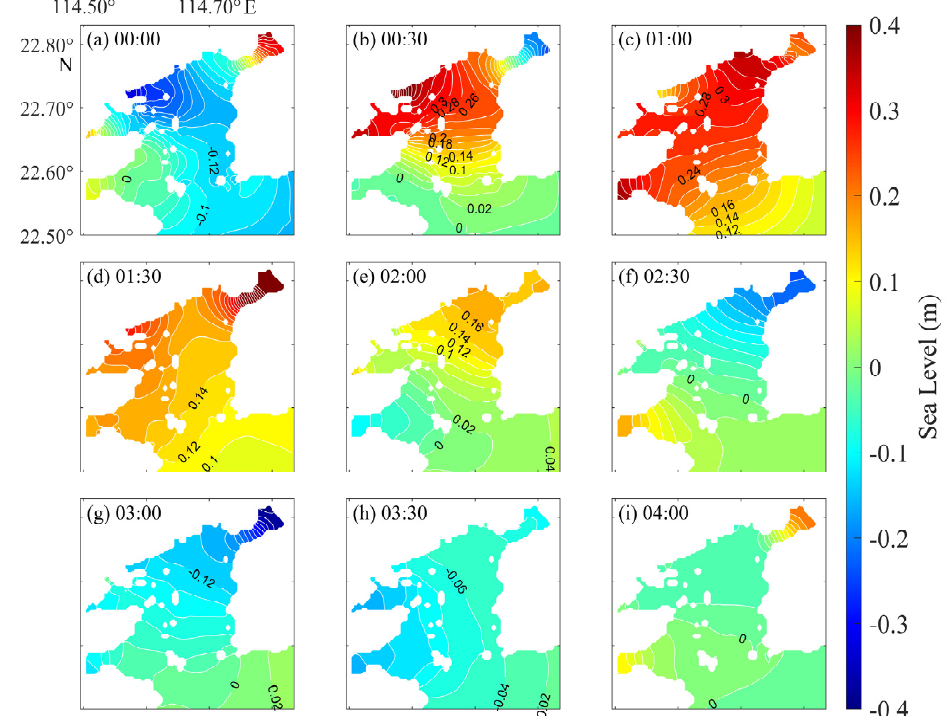
Figure 12. Distributions of instantaneous sea levels produced by the inner sub-model in Daya Bay after a wind pulse in the D–F direction at nine different times ( a – i ) between 00:00 (2 h after the end of the constant wind forcing) and 04:00.